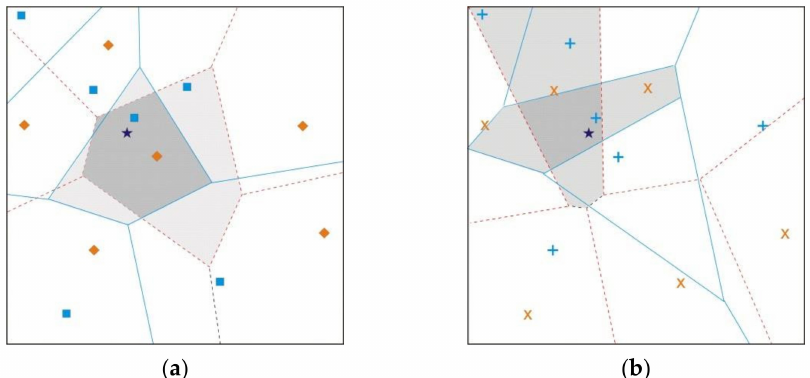
Figure 5. Example of four new groups of anchor nodes using the 12 anchor nodes in Figure 3: ( a ) the third group (squares) and fourth group (diamonds); ( b ) the fifth group (pluses) and sixth group (x-marks).